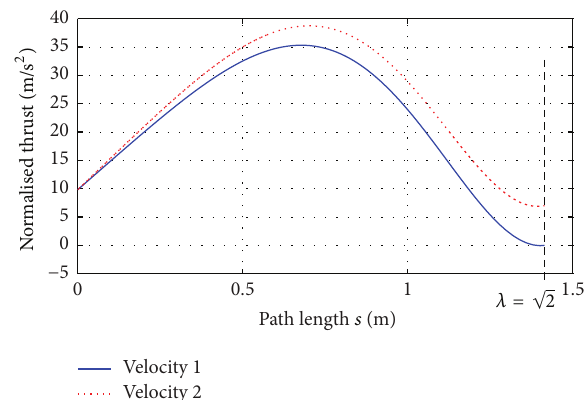
Figure 5: Normalised thrust requirements of one half of a clothoid